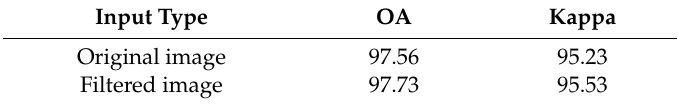
Table 6. Classification performance using the original image and the filtered image as the network input